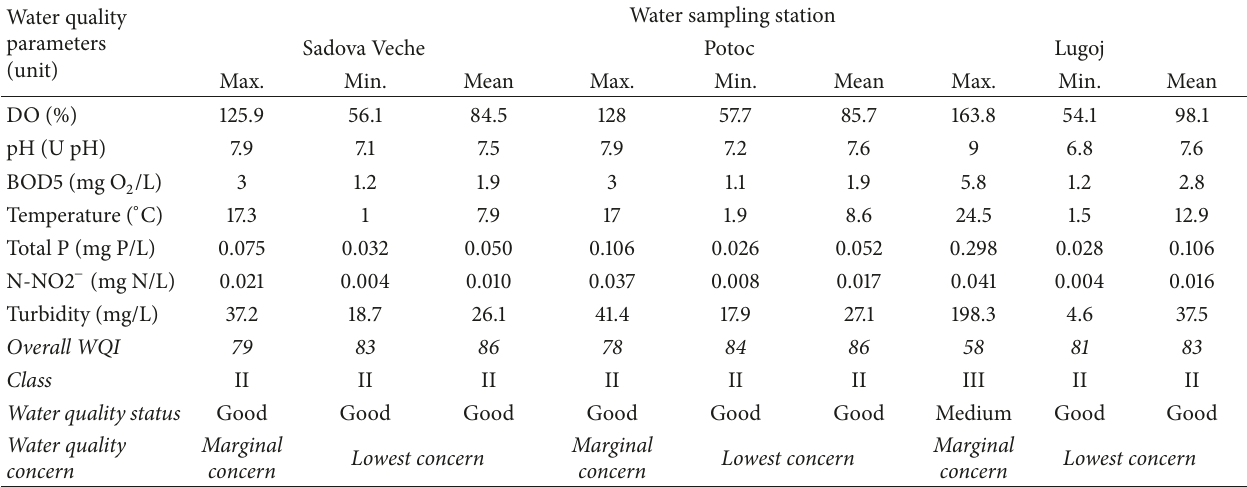
Table 2: Water quality status and WQI values at sampling stations from the Timis¸ River.